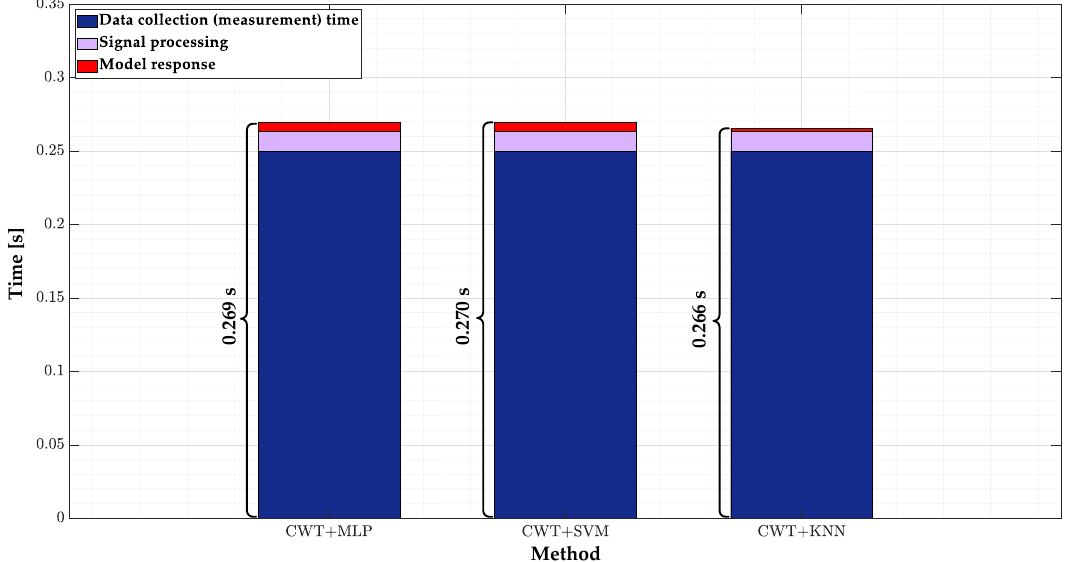
Figure 24. Comparison of the time consumed by different diagnosis techniques.